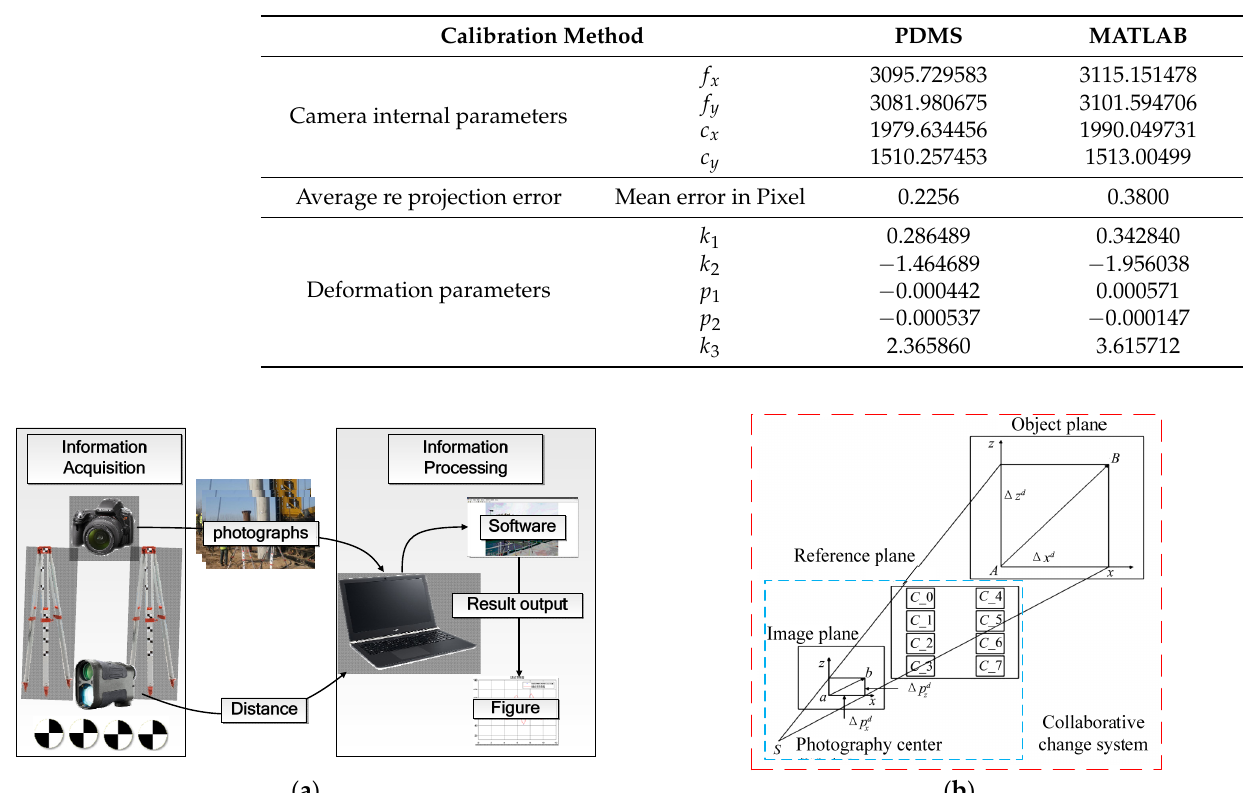
Table 1. Internal camera parameters and distortion coefficients of the Samsung Galaxy S9 rear camera.